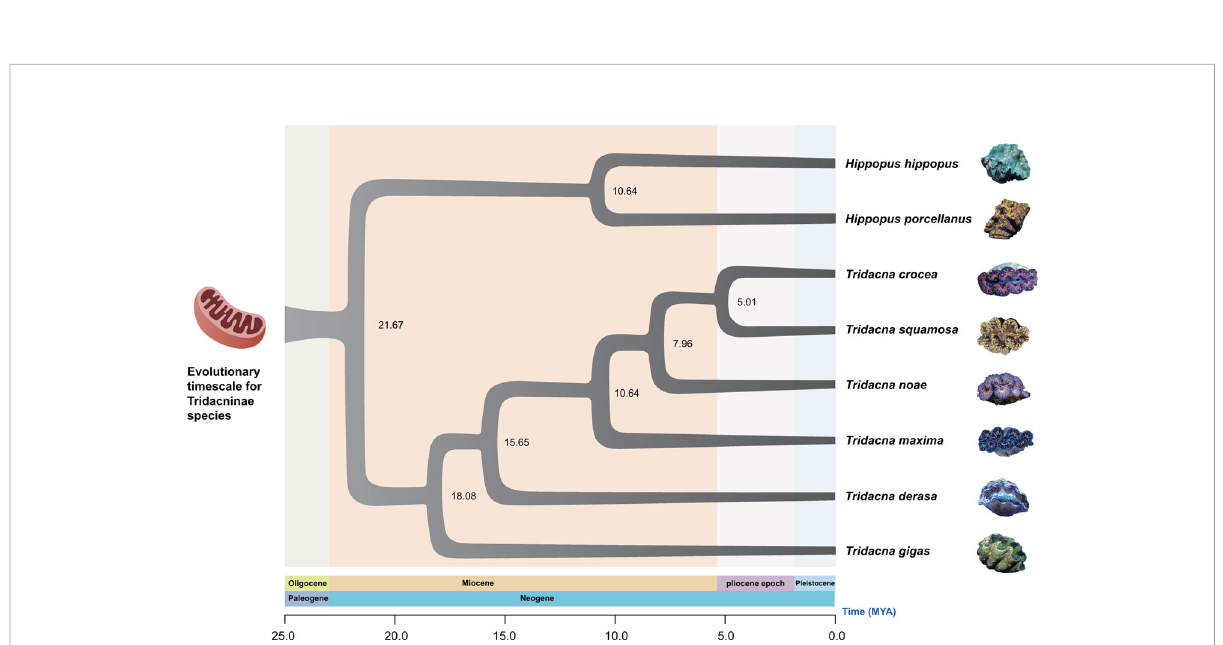
FIGURE 5 Evolutionary timescale for eight giant clam species inferred from a mitochondrial data set comprising 13 protein codons by mtDNA. Numbers at nodes indicate the mean estimated divergence times (in mya).